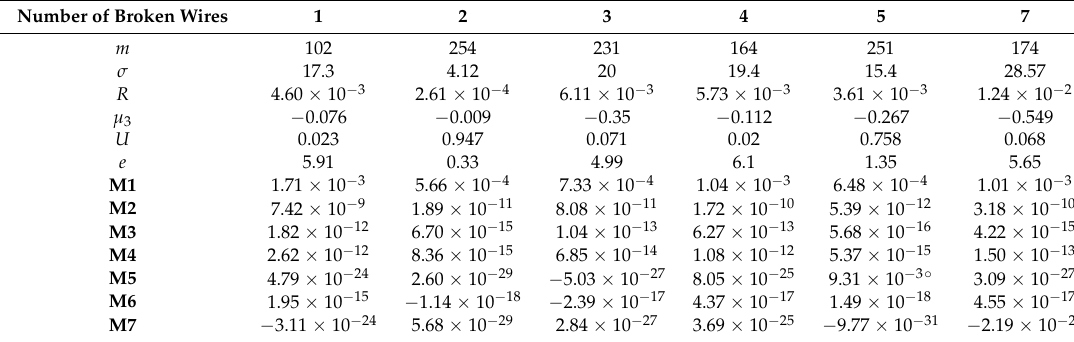
Table 1. Components of the image feature vectors obtained for different wire rope